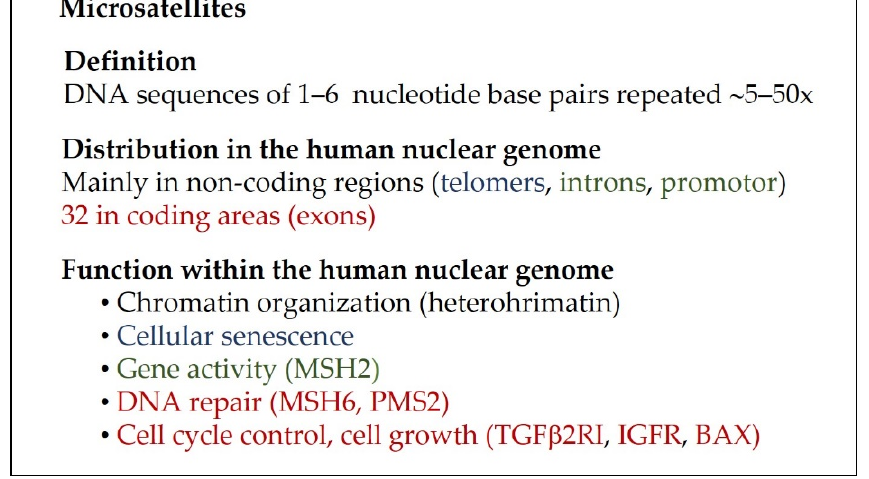
Figure 1. Definition of microsatellites and their functions within the human nuclear genome.